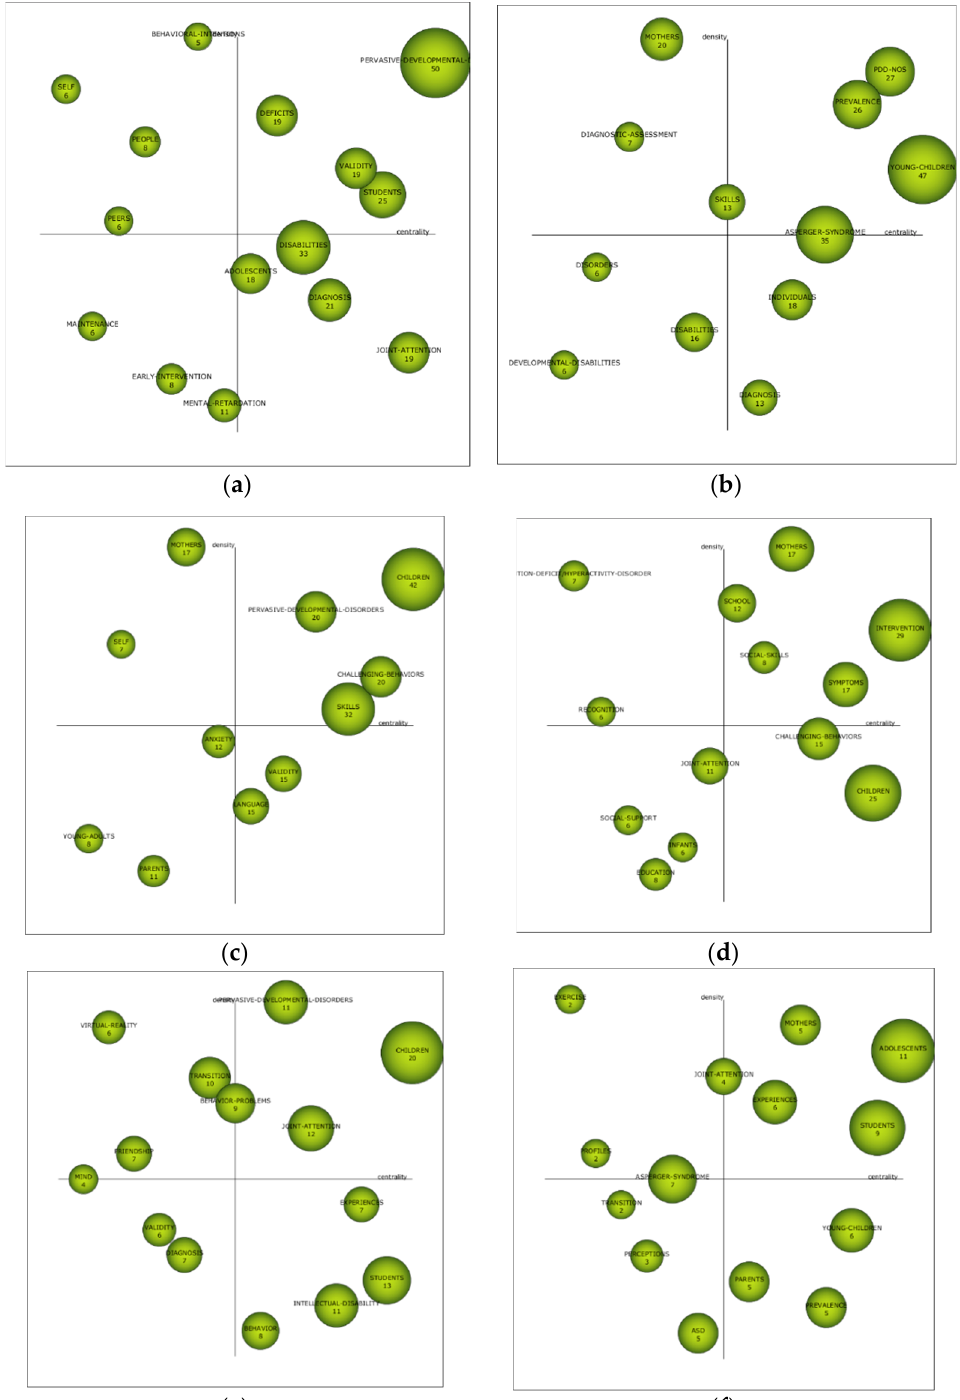
Figure 4. Strategic diagram constructed by ASD-EDU index h. Note: ( a ) interval 1963–2008; ( b ) interval 2009–2011; ( c ) interval 2012–2013; ( d ) interval 2014–2015; ( e ) interval 2016–2017; and ( f ) interval